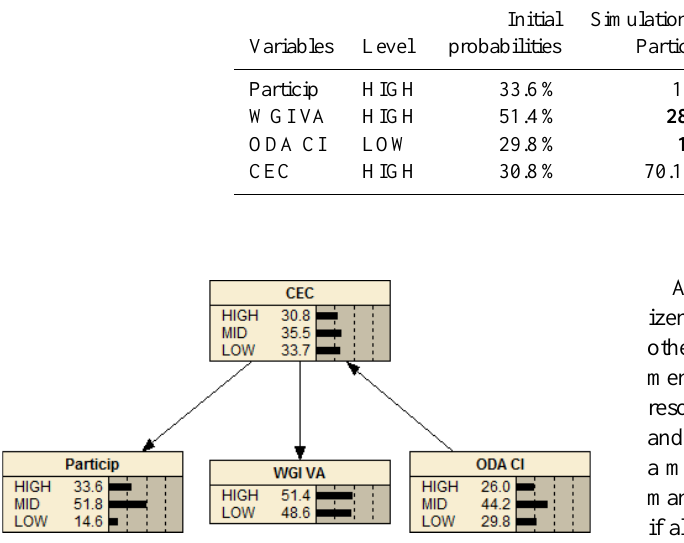
Fig. 5. Probabilities in % for the variables involved in the CEC pillar discretised in high (HIGH), medium (MID) and low (LOW)